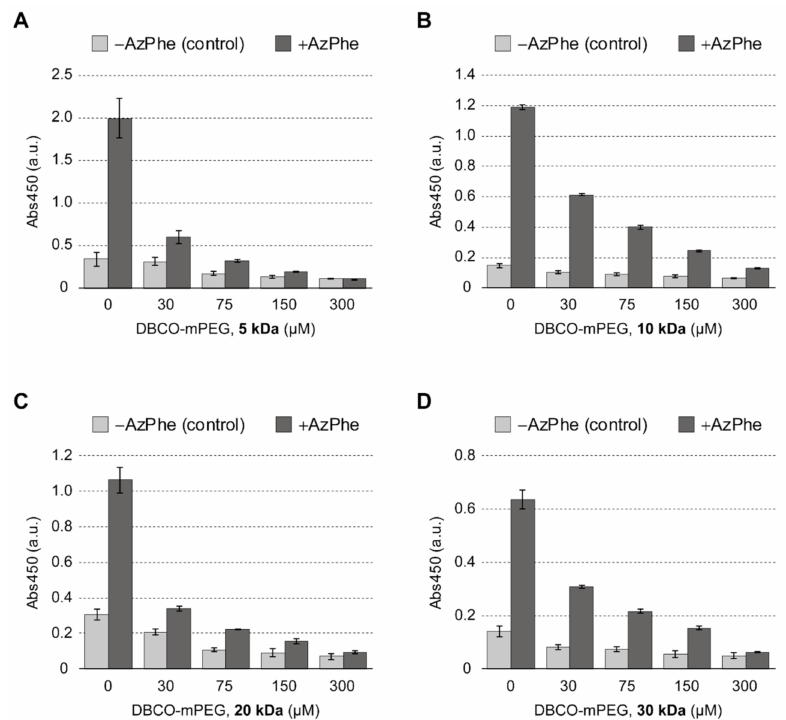
Figure 2. Detection of unreacted azido groups in AzidoSilk film on cell culture plates after SPAAC reactions with DBCO-mPEG of di ff erent chain lengths: ( A ) 5 kDa, ( B ) 10 kDa, ( C ) 20 kDa, and ( D ) 30 kDa. The concentrations of DBCO-mPEGs were changed from 30 to 300 µ m to find an appropriate reaction condition under which to achieve saturation of reactions with DBCO-mPEG. Unreacted azido groups were reacted with sulfo-DBCO-biotin. Biotins were detected by coloration with an HRP substrate after conjugation with HRP-streptavidin. The averaged UV absorbance at 450 nm from four wells was plotted with error bars of standard